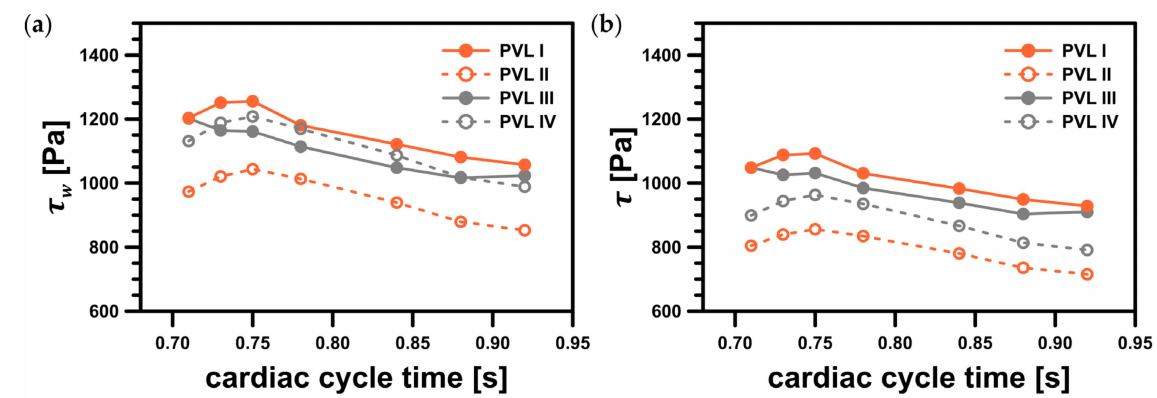
Figure 9. Maximum shear stress values in the considered system: ( a ) maximum wall shear stress, τ w ; ( b ) maximum shear stress magnitude, τ . Both variables represent values in a specific point; facet maximum for wall shear stress and cell maximum for shear stress